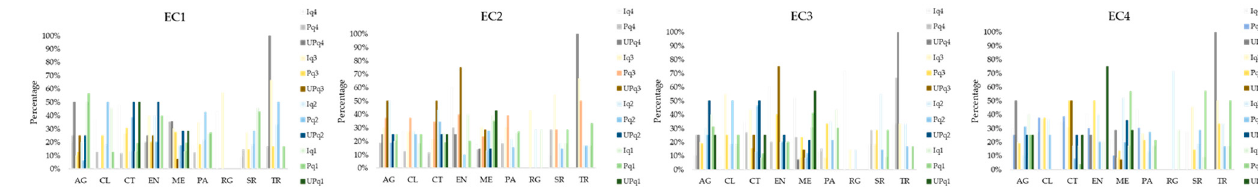
Figure A1. Comparison of the percentages of municipalities for different metropolitan cities in Sicily based on the quartiles of indicators for economic capital, and the NSIA classification. (Authors’ elab- oration.)